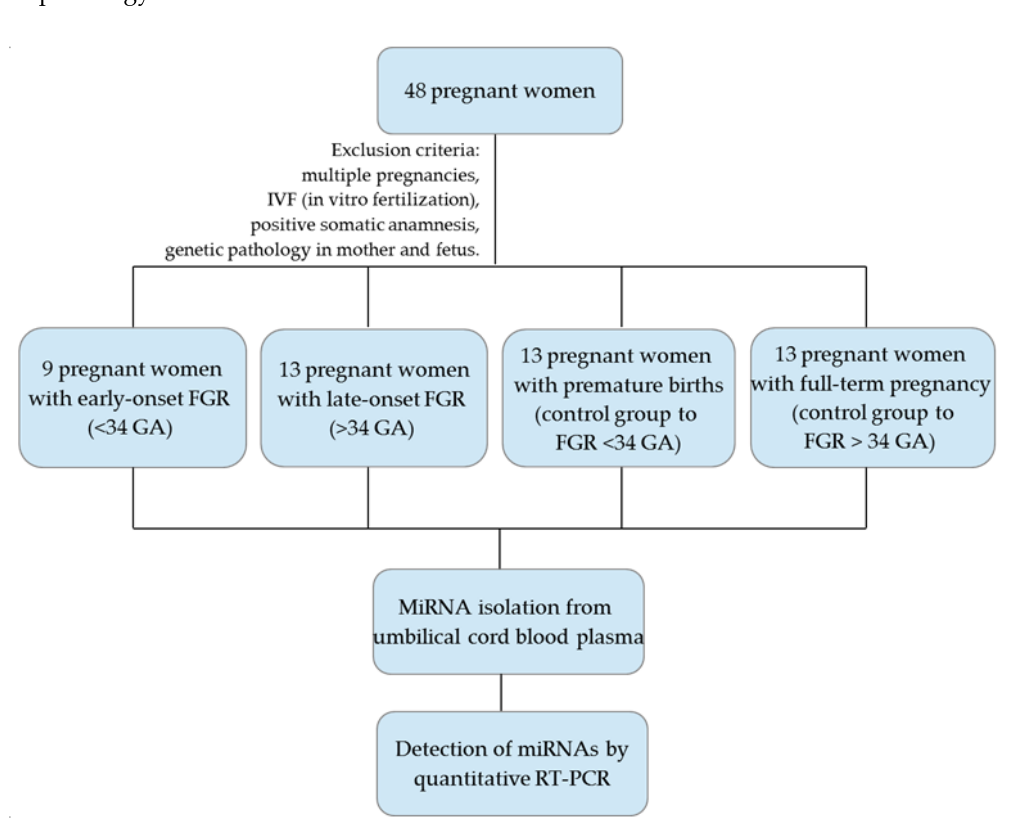
Figure 1. Flowchart of the study population.